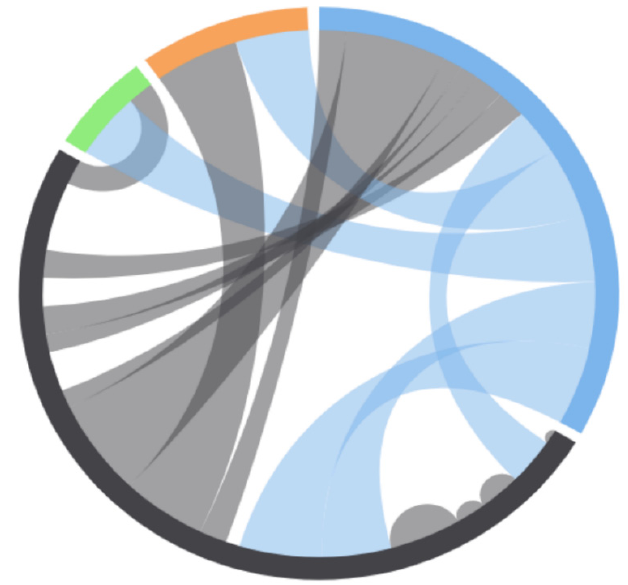
Figure 10. The percentages of the polarity (very positive, positive, neutral, negative, and very negative) labels are connectivity based on vaccines, and each color represents a label. Table 4. The final results compared between (SA-CD19-EL) and other methods for the fake news dataset.